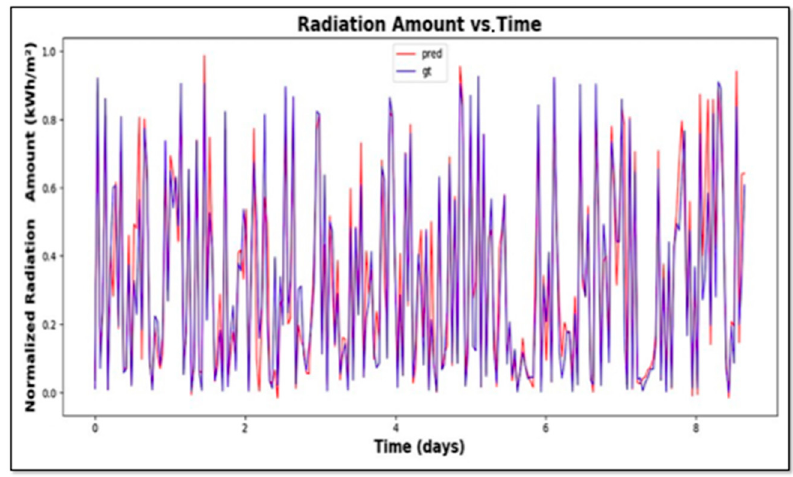
Figure 9. Radiation of 175 days (testing days) as LSTM predicted (blue) versus the ground truth as measured (red).